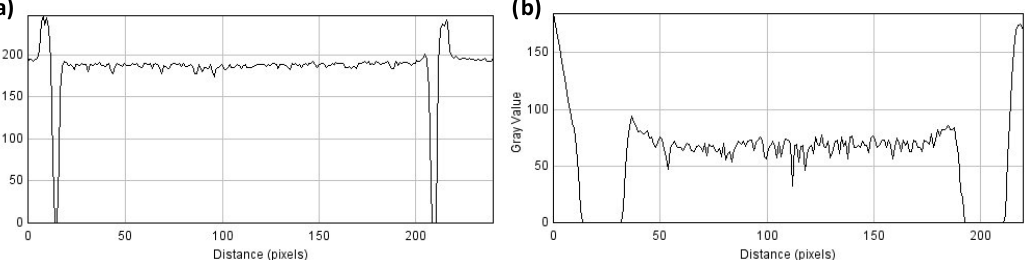
Figure 4. Plot profile obtained from the recordings of the BAF flow through the microchannel at the ( a ) inlet and ( b ) outlet one/nine using the software ImageJ (1.48v). The zero value indicates a black pixel, which corresponds to the channel walls. Consequently, the values between those points were the ones considered for the average calculation.